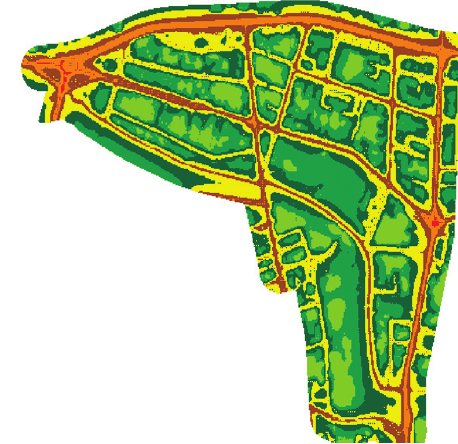
Fig. 9. Modelled noise level of segment 2 of the central part of Panevėžys city by night